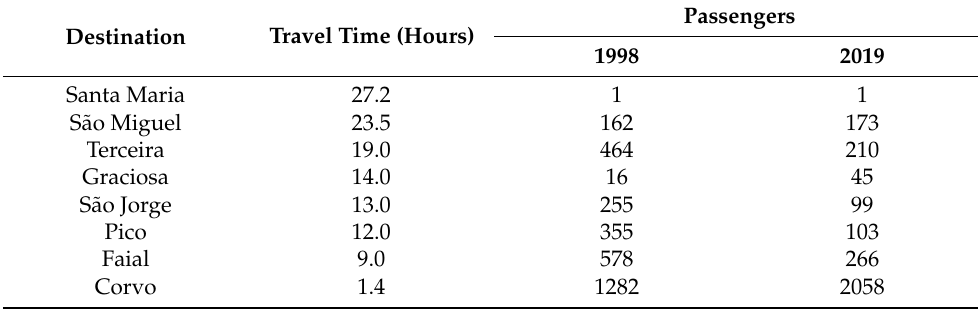
Table 5. Data for maritime connections to Flores Island from the rest of the archipelago—for 1998 and 2019.